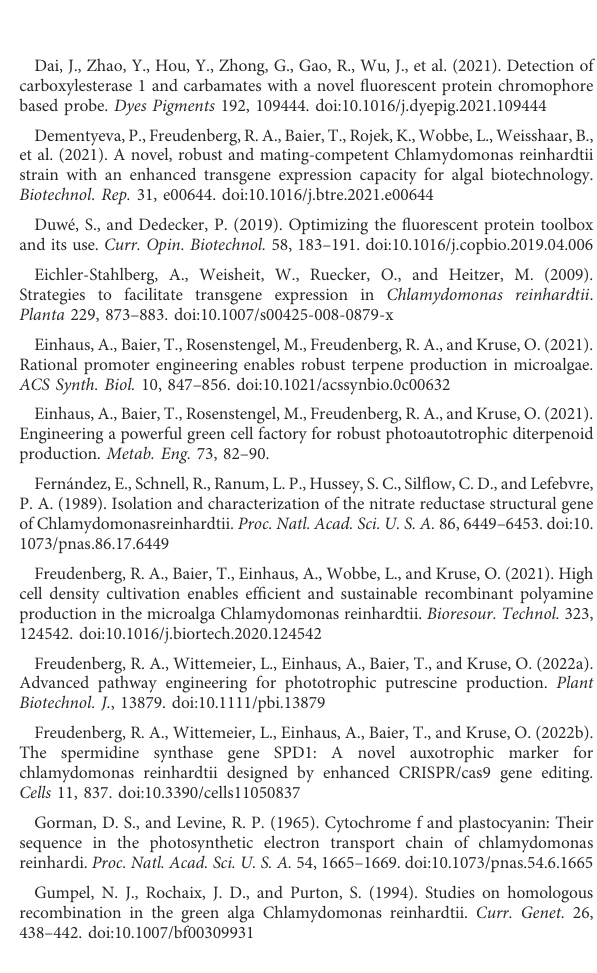
different fl uorophores were streaked by hand onto an agar plate containing amido black and imaged after 24-h growth. Black and white images captured in the ChemStudio plus with indicated fi lters. Labels: P — Parent strain, T — mTFP1, LSS — LSSmOrange, Y — mVenus, KO — mKOk, N, mNeptune2.5. SUPPLEMENTARY FIGURE S5 Raw images of in-gel fl uorescence images captured using different fi lter sets. Filters and exposure times as indicated in fi gure. SUPPLEMENTARY FIGURE S6 Cartoon representation of the mVenus-BpsA and mVenus- Pa PcpS expression plasmids, colony (right) and in-gel fl uorescence expression analysis (left). Both fl uorescence images were taken using 504/ 10excitationand530/10emission fi ltersfor30 sofexposure.Fullplasmid sequences with annotations can be found in Supplementary Material S1. M — protein ladder (marker), lanes 1-3 transformants expressing mVenus-BpsA, 4-6 transformants expressing mVenus- Pa PcpS (PPTase), P — parent, C — empty control lane, YFP — transformant expressing the mVenus (YFP) reporter alone. SUPPLEMENTARY FIGURE S7 Images of whole membrane exposures for Western blots of various epitope tags presented in Figure 4. — Antibodies as indicated per each blot image. (I) — CBB — Coomassie brilliant blue staining of one representative gel of 8. (J) — Fluorescence signal of mVenus reporter with the capture settings indicated for one representative gel also used in the blot of (H)